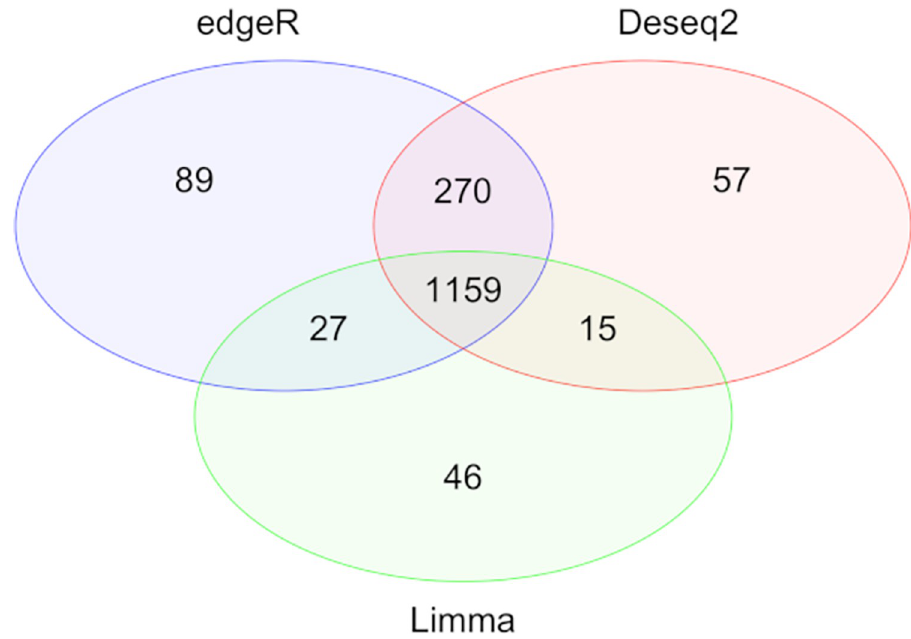
Fig 5. Venn Diagram of DEGs between HFE and IFE chickens obtained from Limma, edgeR and Deseq2.